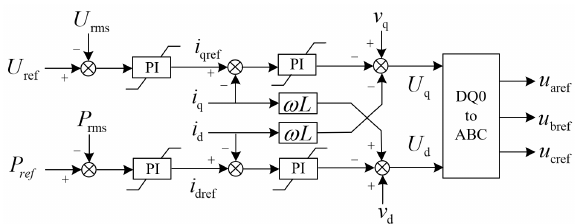
Fig. 2. Schematic diagram of double loop decoupling